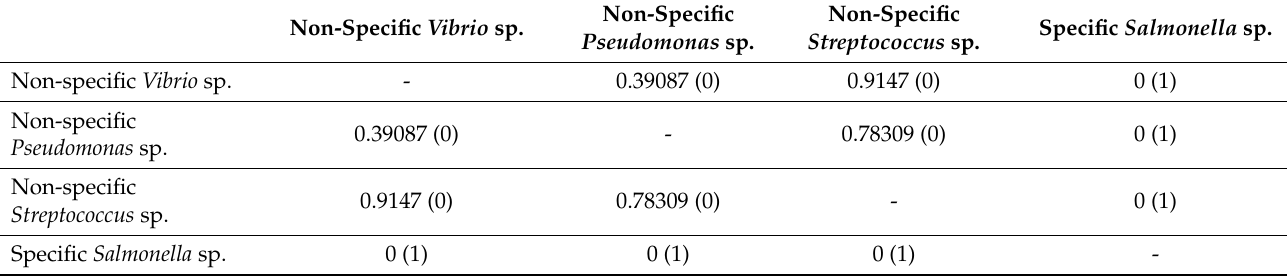
Table 5. Sensitivity analysis of sensor among various test samples. p -value for each pair of data analyses using one-way ANOVA. The significance value (0, 1) provided in parenthesis beside the p -value denotes the significance for each pair of data. Significance value 1 indicates that the data pairs are significantly different ( p -value lesser than 0.05). The significance value 0 depicts that the data pairs are not significantly different ( p -value greater than